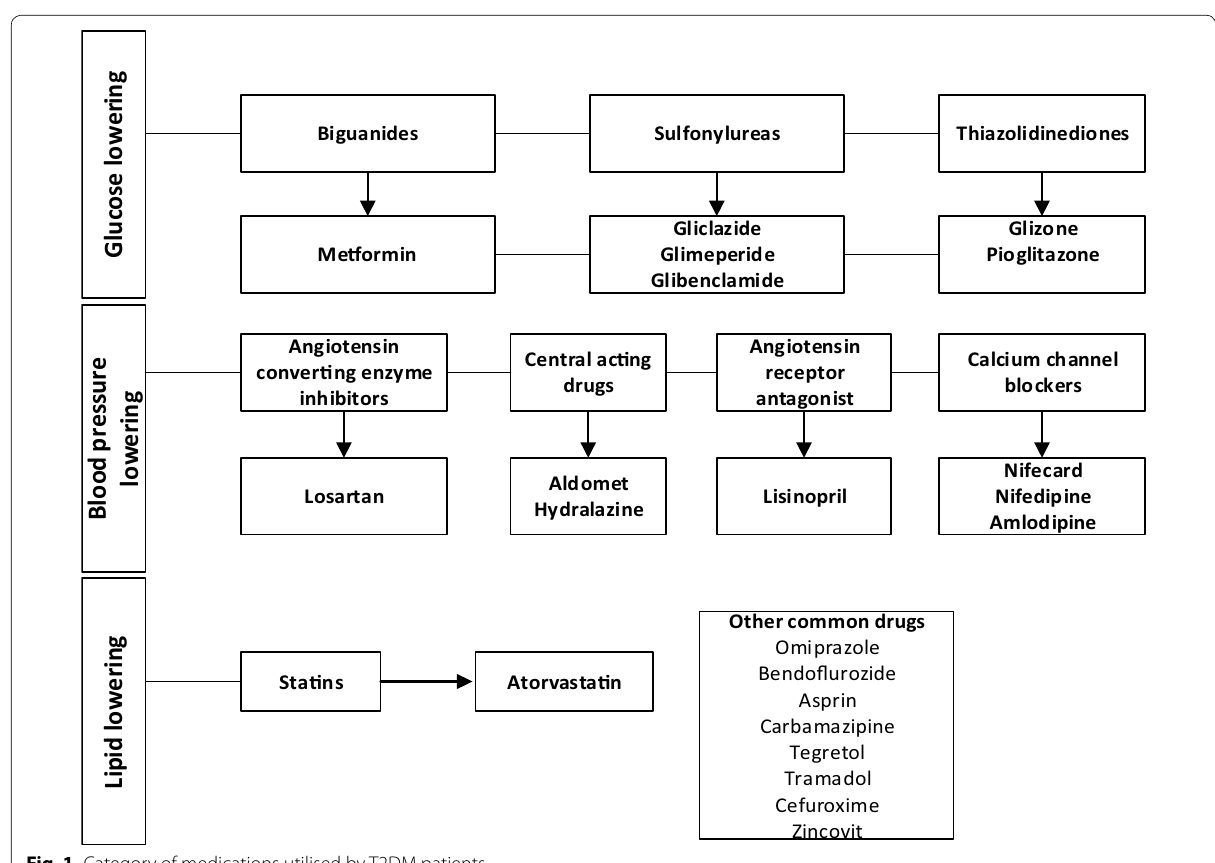
Fig. 1 Category of medications utilised by T2DM